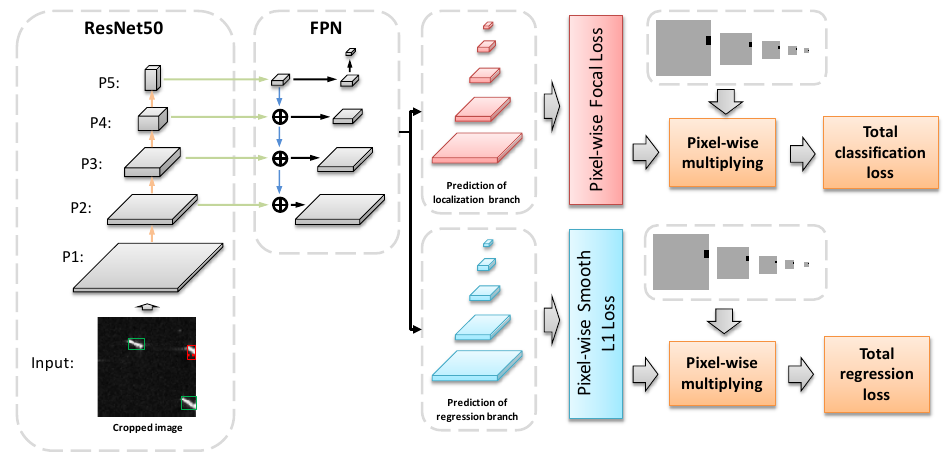
Figure 19. Loss calculation process of RetinaNet with the proposed method. Table 5. Experimental results on anchor-based model RetinaNet (ResNet50). Crop